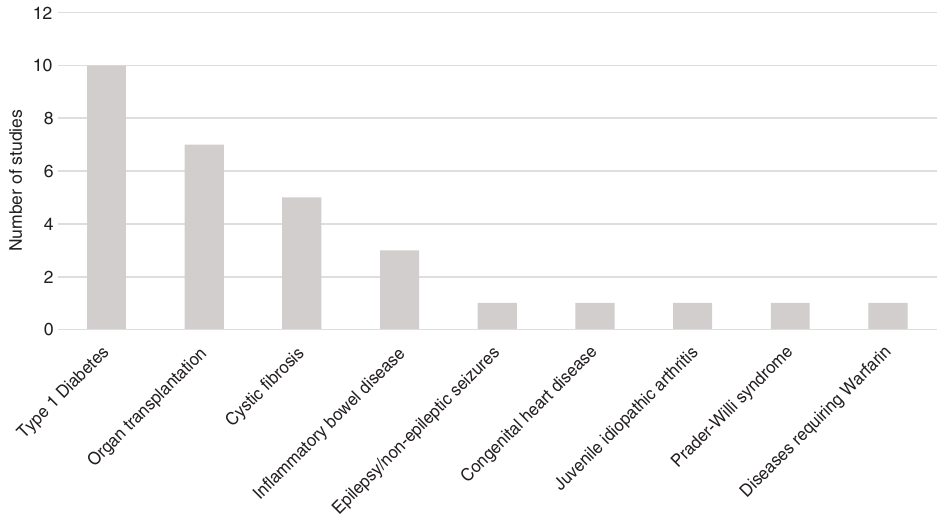
Figure 2: Number of studies that used samples with certain chronic health conditions. Outcomes